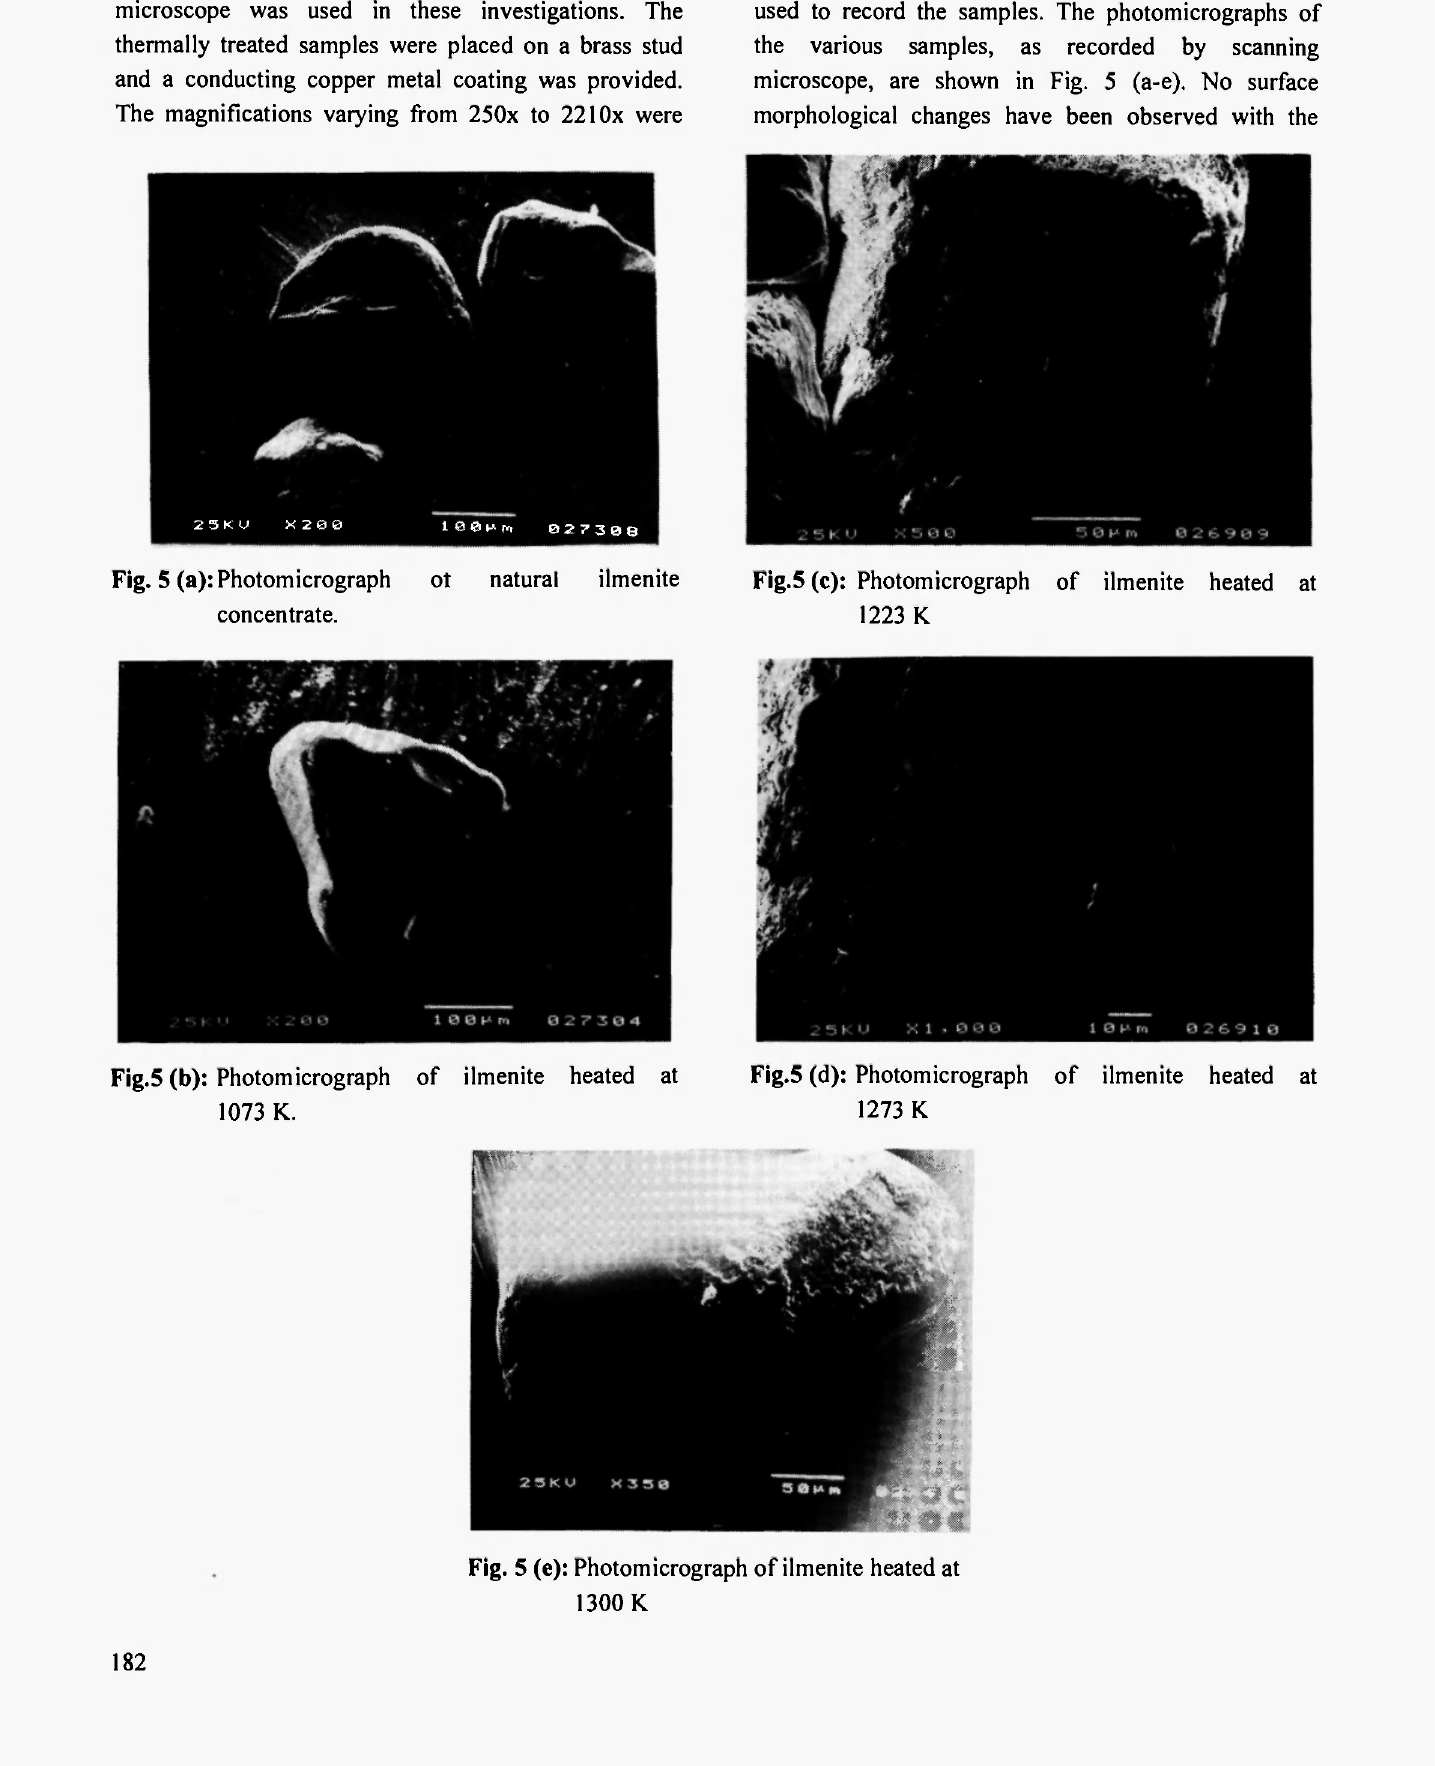
Fig.5 (c): Photomicrograph of ilmenite heated at 1223 Κ